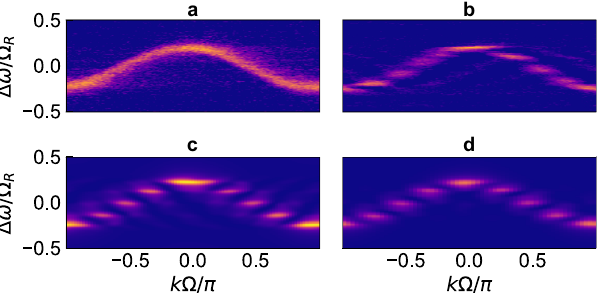
Fig. 4 Band structure of bulk and fi nite lattices in one